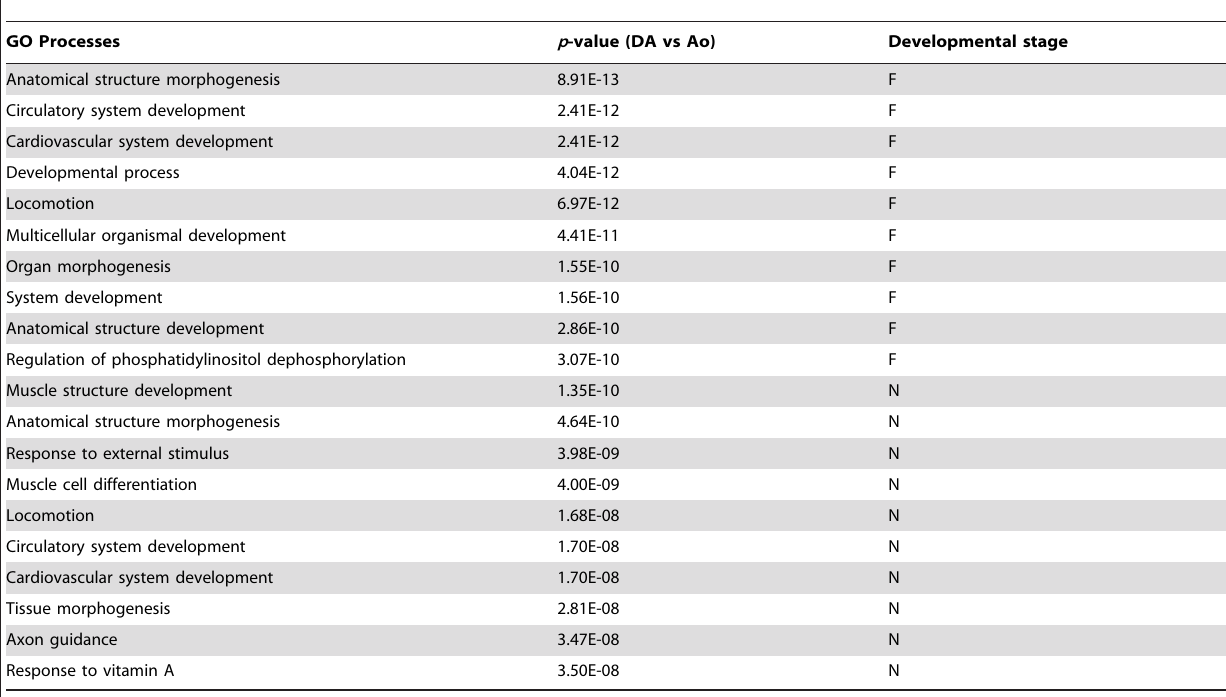
Table 5. Top 10 regulatory biological processes worked in the DA ECs.